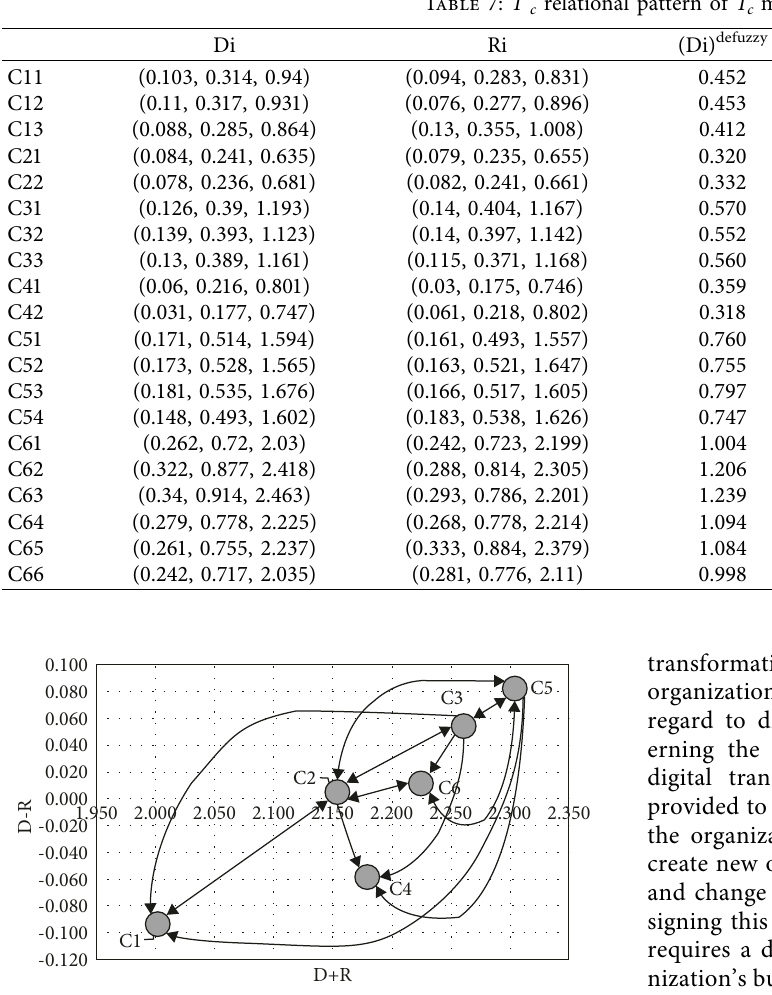
Figure 3: Causal diagram of the main